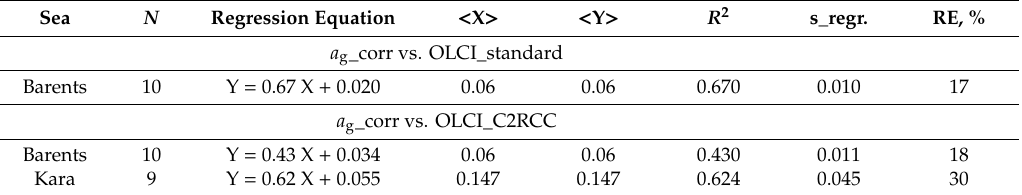
Table 4. Regression equations for calculation of the absorption coe ffi cient from OLCI data.